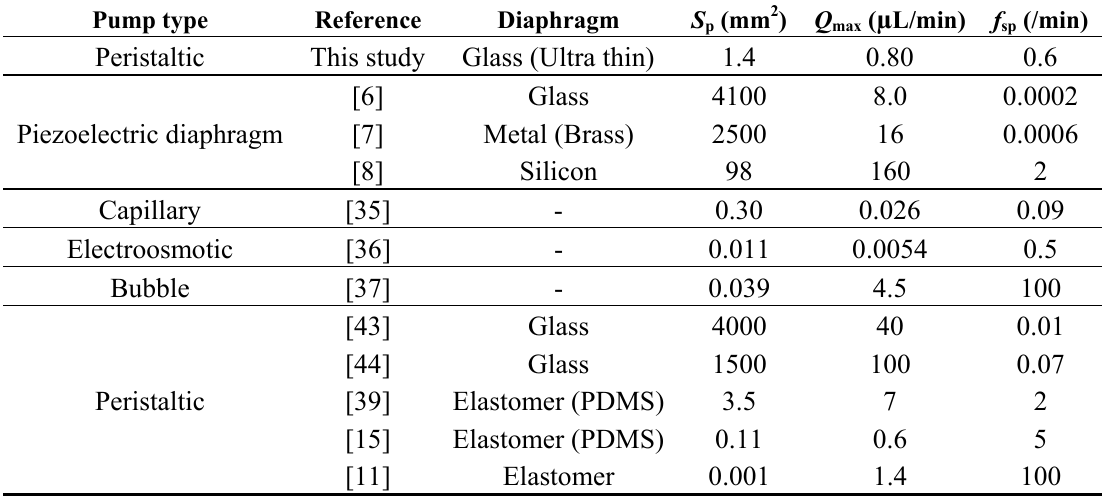
Table 1. Performance comparison of the demonstrated pump with other pumps regarding diaphragm materials, S (package size), Q p delivery), and f (self-pumping frequency). S sp one significant